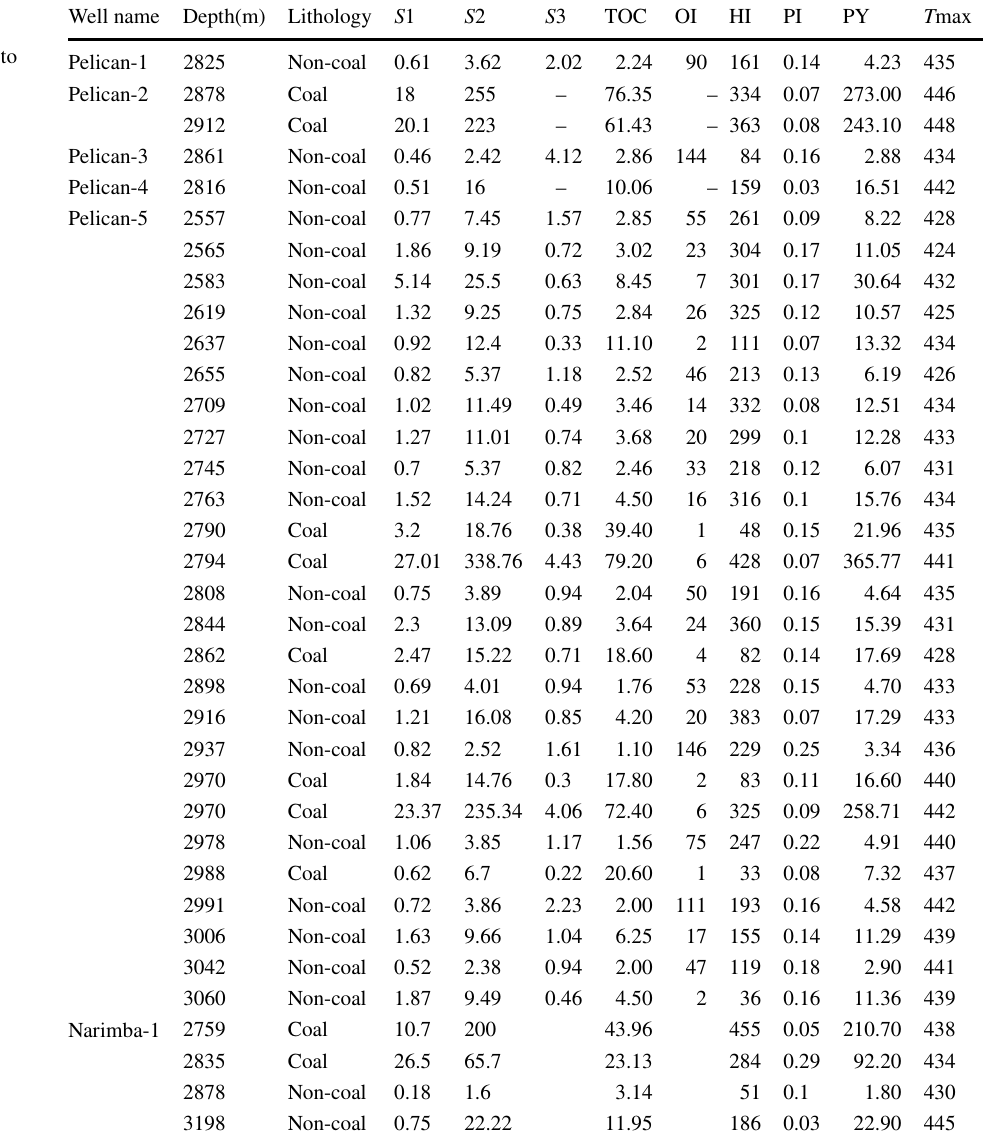
Table 2 Rock–eval pyrolysis results for the Narimba Formation in wells Pelican-1 to 5 and